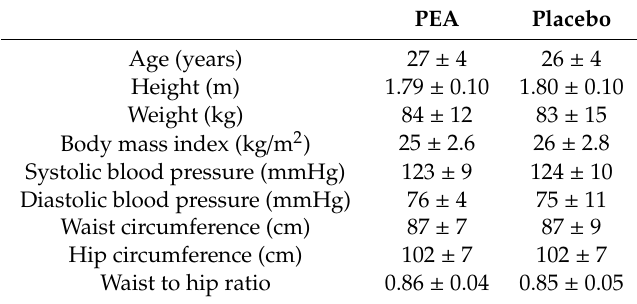
Table 1. Baseline participant characteristics for palmitoylethanolamide (PEA) and placebo groups. Values are mean ±